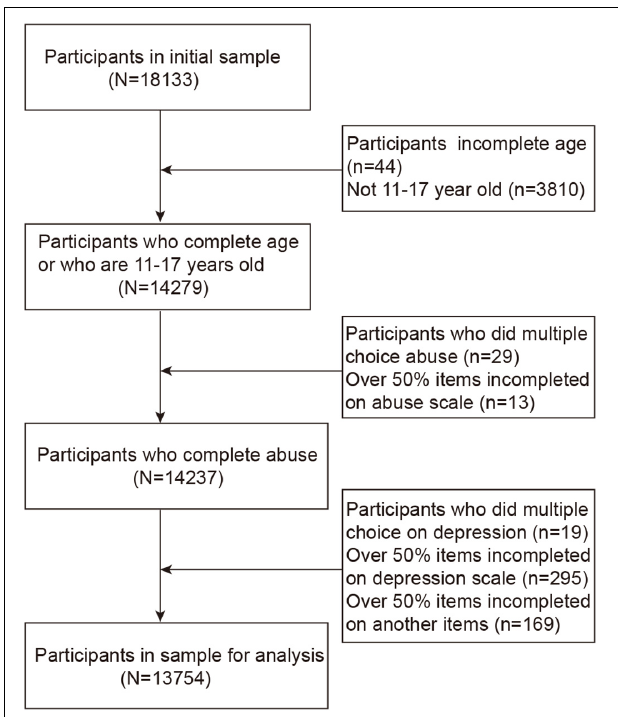
FIGURE 1 | Flow of participants in the